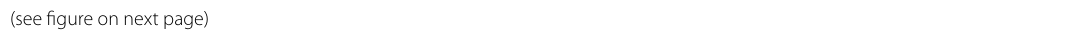
Fig. 2 A 34-year-old female presented with right breast lump. Pre-therapy : a Right breast lower inner quadrant indistinct mass with extensive skin edema (peau d’orange). The mass showed delayed peak of contrast uptake at 274 s with corresponding signal intensity percentage of 58% and delayed washout curve pattern type Ib. b Right lower inner quadrant mass (ADC value peak 0.9 mmol/l). Histopathology : Invasive ductal carcinoma, grade III. Immunohistopathology : Negative for ER and PR, positive for HER2/NEU (class = 3 ), Ki 67 high proliferation index. Treatment decision : Neo-adjuvant chemotherapy and modified radical mastectomy. Post-therapy : d Regressive + course regarding the size of the right lower inner quadrant mass. The right breast dominant mass (at the upper inner quadrant) showed faint contrast uptake. Kinetics displayed signal intensity percentage of 35% and progressively rising curve pattern- type I. Also, there was mild regression of previously noted dermal edema seen. e DWI showed restricted diffusion and an ADC value of 0.730 0.4 mmol/l height value. Pathology report of the surgical specimen : Gritty mass with wide area of necrosis (partial tumor response). Free deep surgical margins. Metastatic deposits were found in 7 from 12 dissected axillary lymph nodes. Comments : Partial pathological and